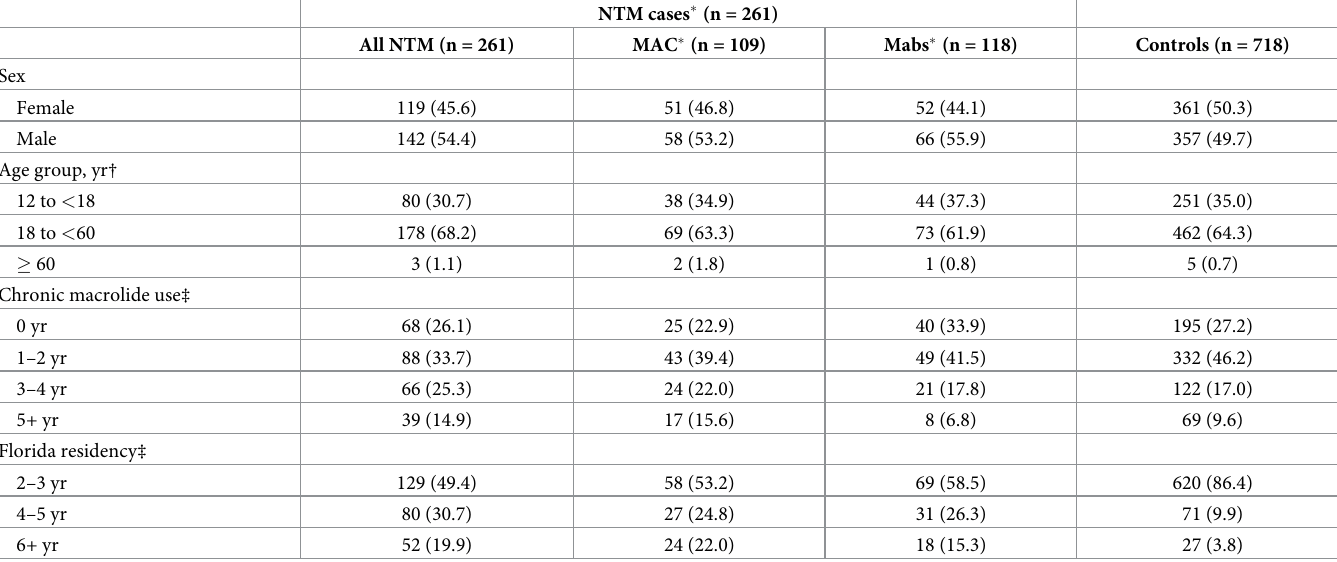
Table 2. Baseline demographics of the study population by NTM culture result, Florida,